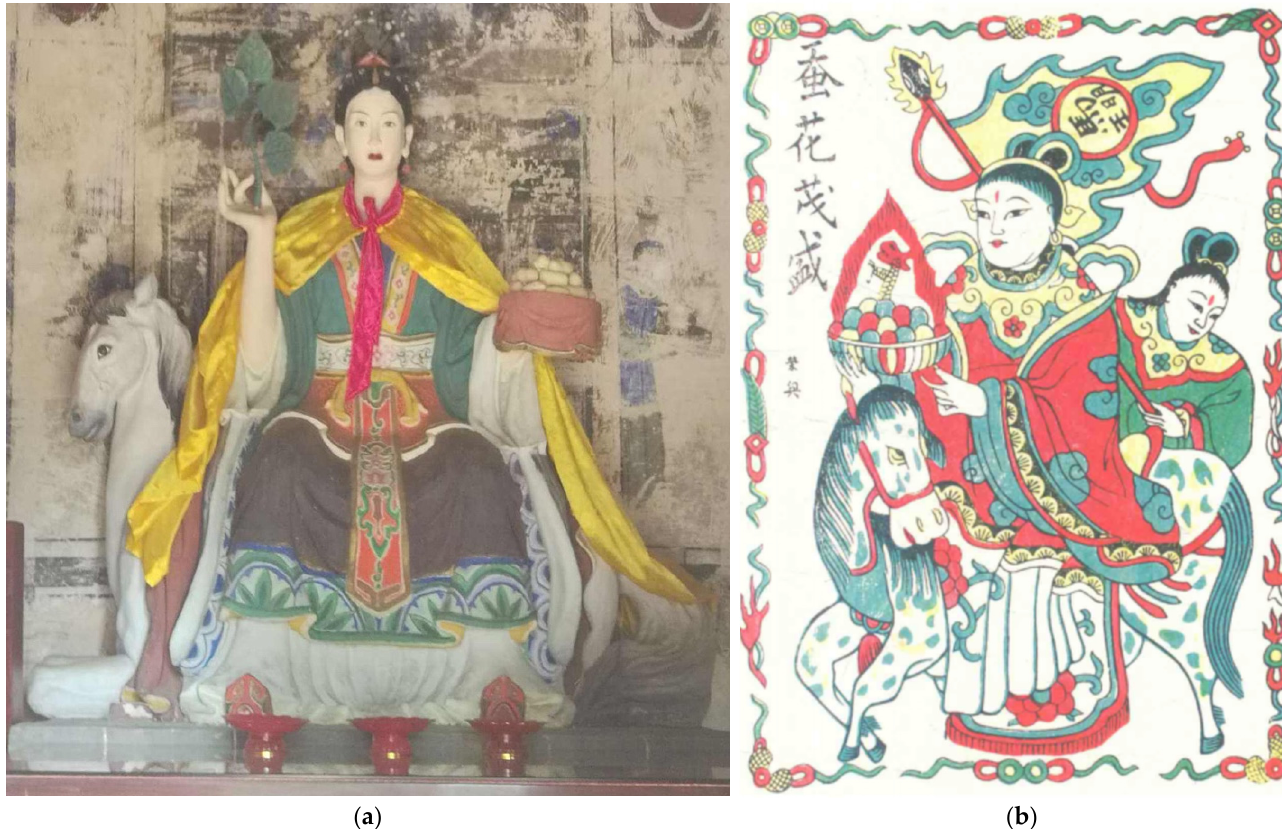
Figure 7. “Ma-Tou-Niang”: ( a ) The statue of “Ma-Tou-Niang”. Mian-Hua-Dian 棉花殿 , Jinan, China. Photograph taken by the authors; ( b ) Can Hua Mao Sheng 蚕花茂盛 ” (Shen 2015, p. 225). Taohuawu 桃花坞 Wood Engraving New Year pictures.